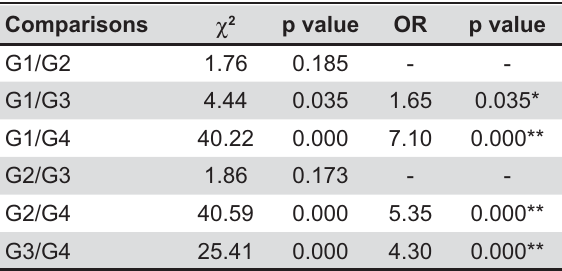
Table 2- Association between breastfeeding duration and prevalence of anterior open bite, with odds ratio (OR) calculation, in the total sample (n=1,377)